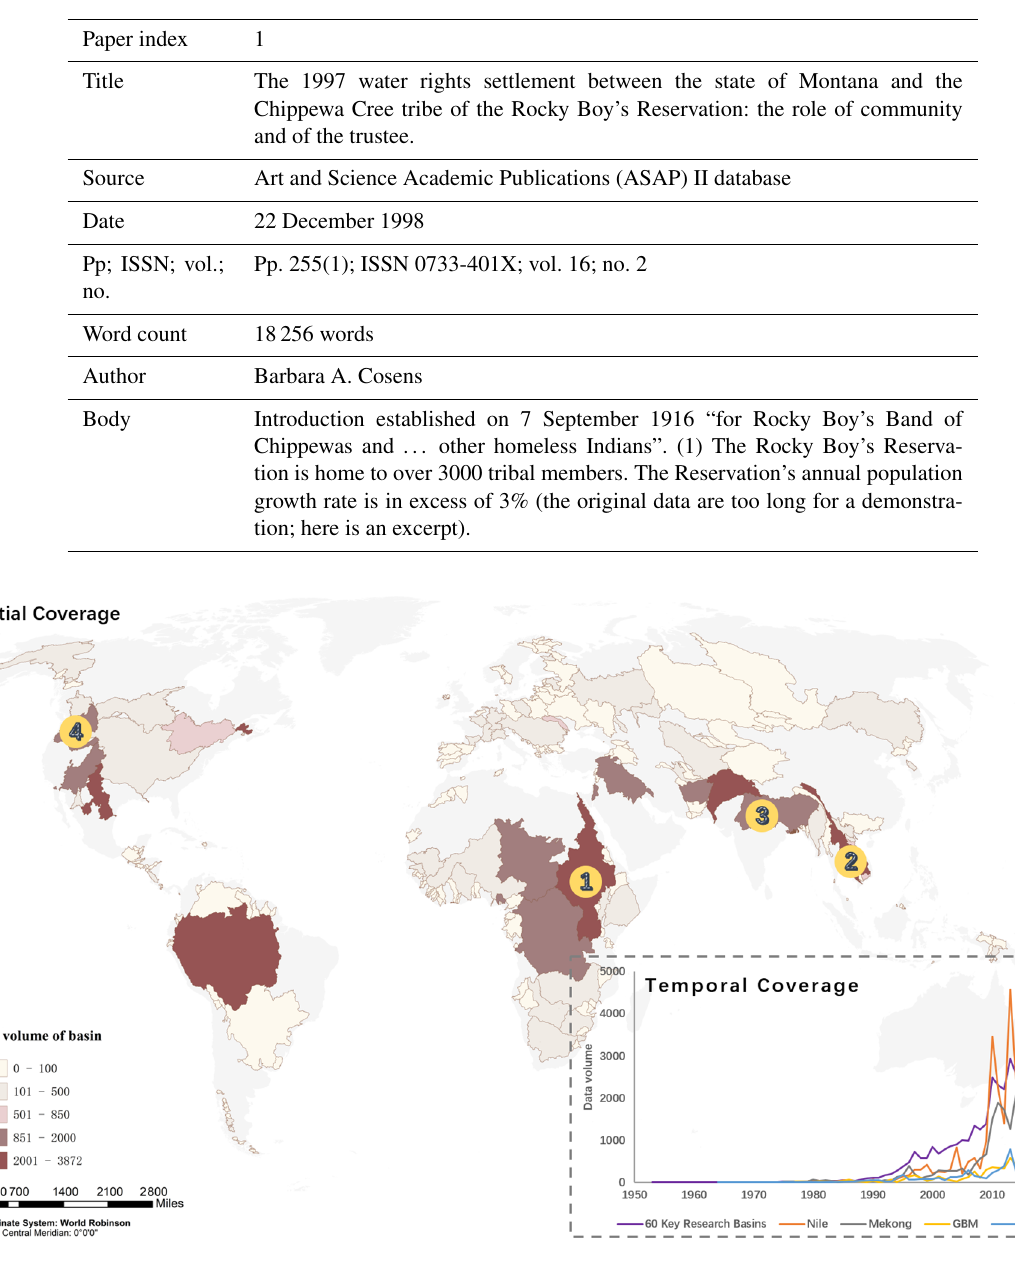
Table 4. Example of structured data.